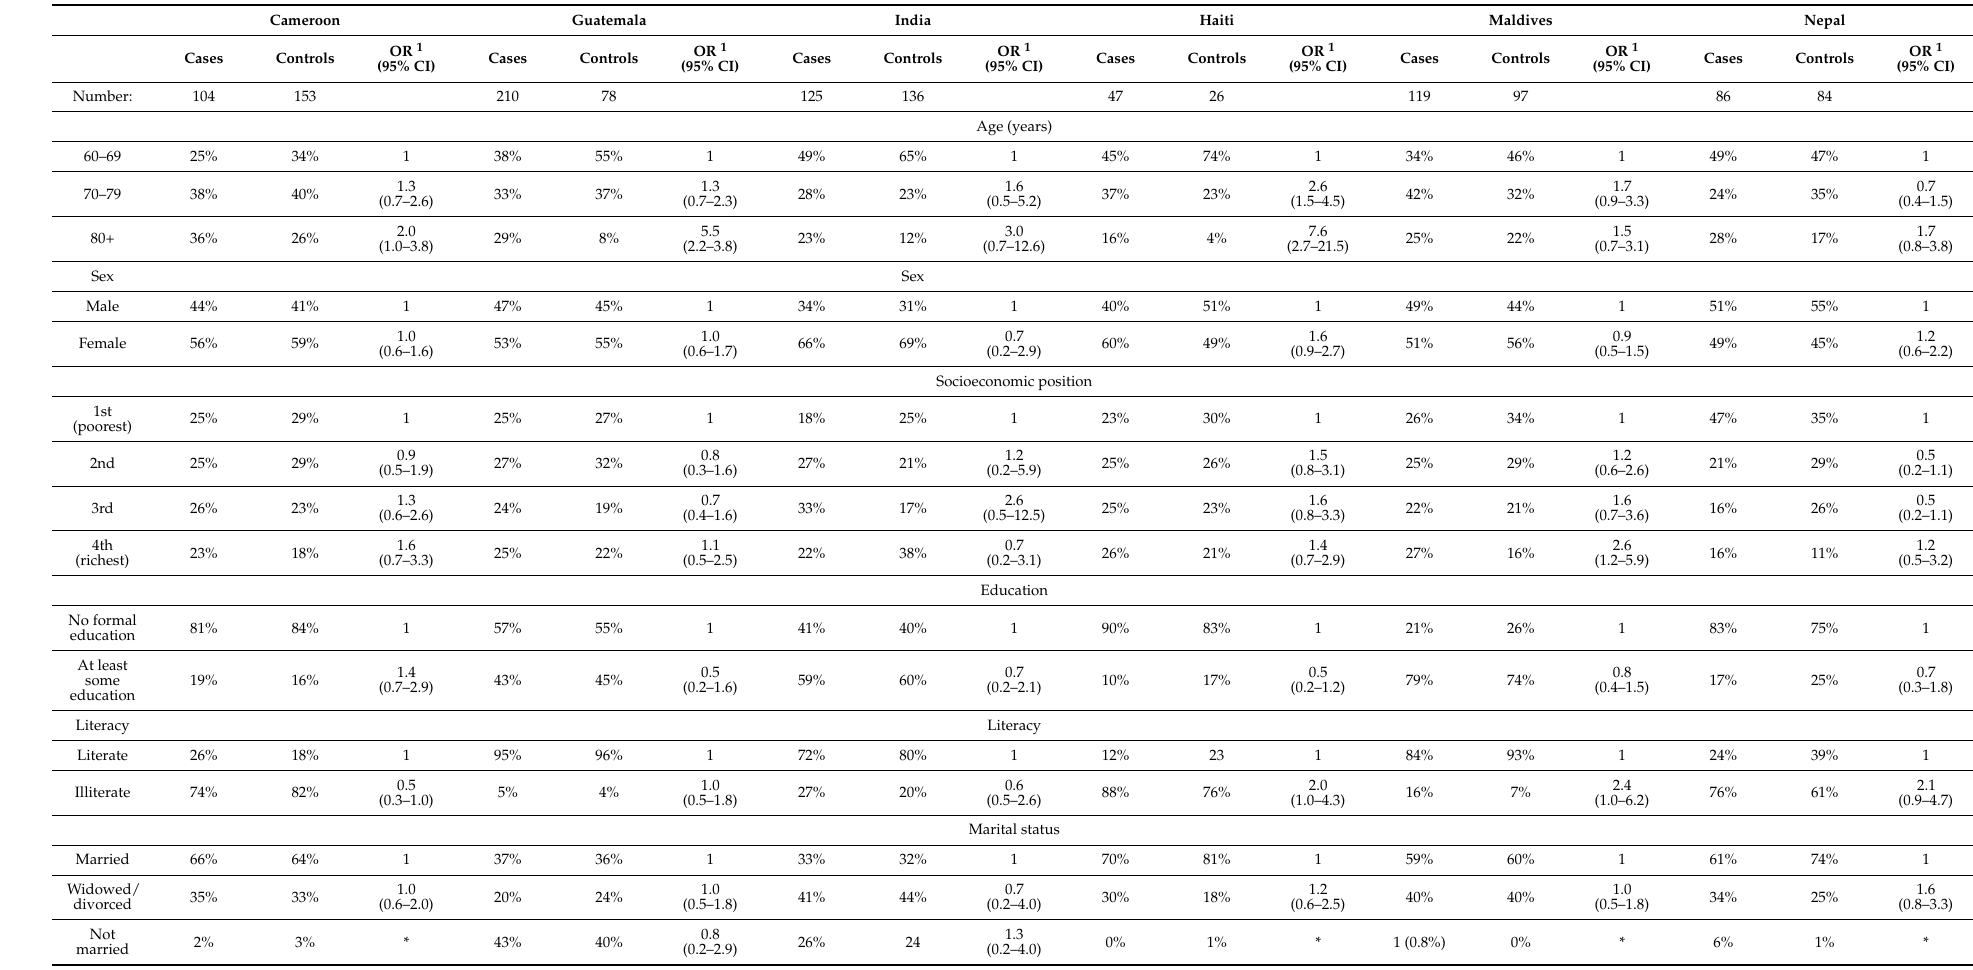
Table 2. Comparison of older people with disabilities (‘cases’) and without disabilities (‘controls’) in sociodemographic characteristics. Cameroon Guatemala India Haiti Maldives